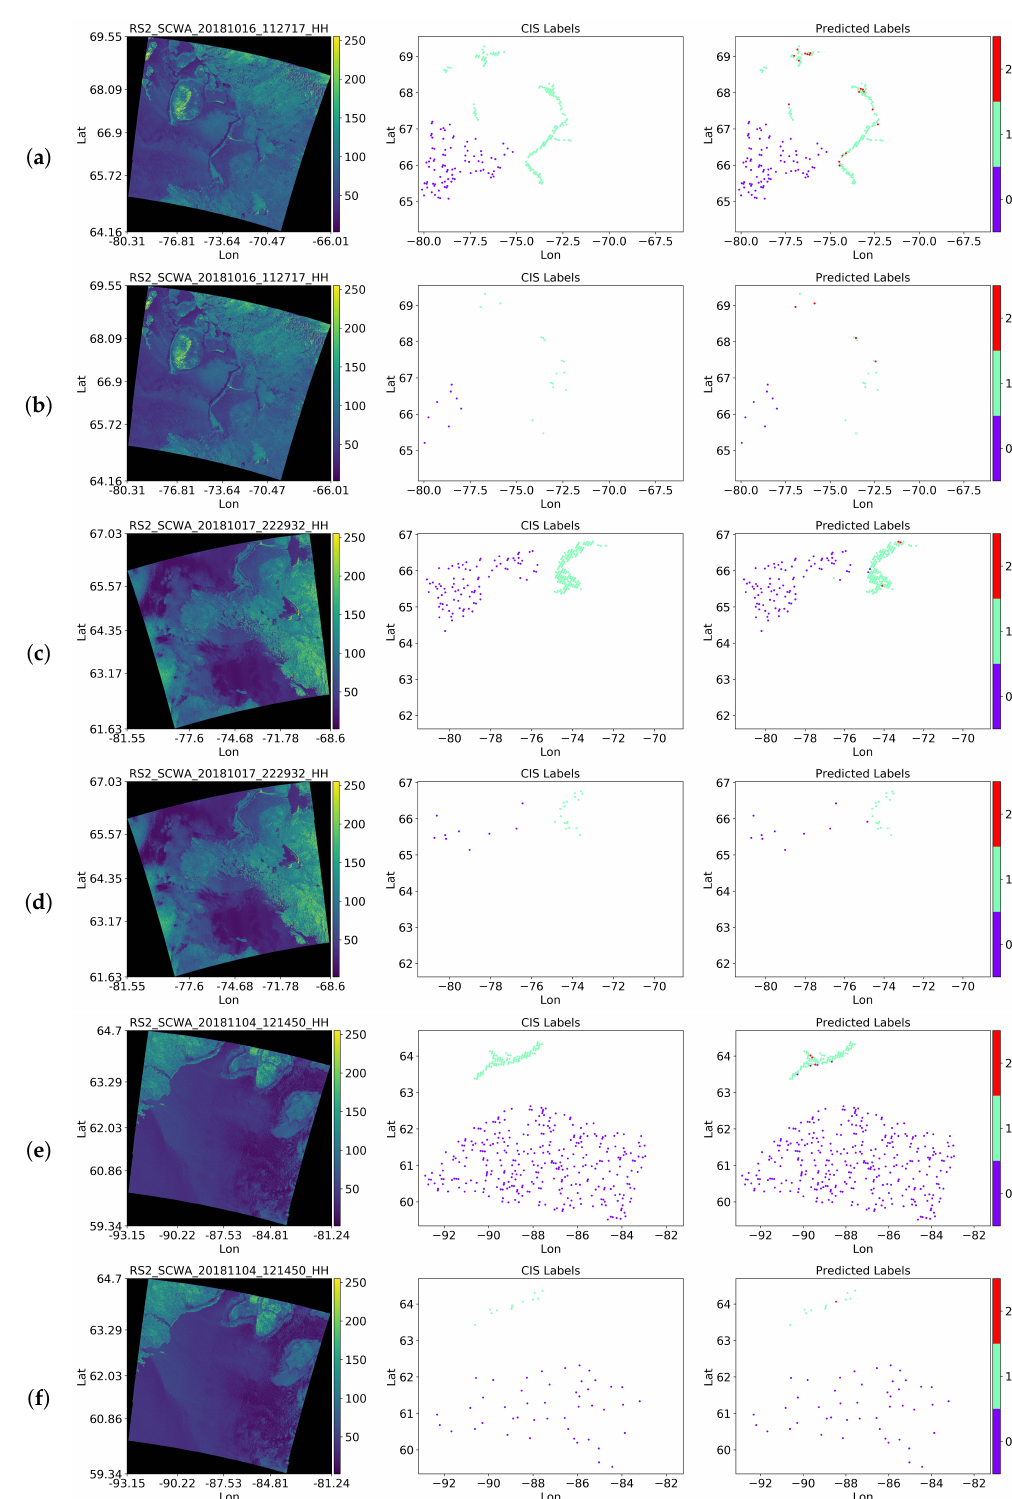
Figure 5. A visual representation of training and testing samples from three SAR scenes and the predictions from DenseNet. ( a ) Training samples from 2018/10/16 11:27:17. ( b ) Testing samples from 2018/10/16 11:27:17. ( c ) Training samples from 2018/10/17 22:29:32. ( d ) Testing samples from 2018/10/17 22:29:32. ( e ) Training samples from 2018/11/04 12:14:50. ( f ) Testing samples from 2018/11/04